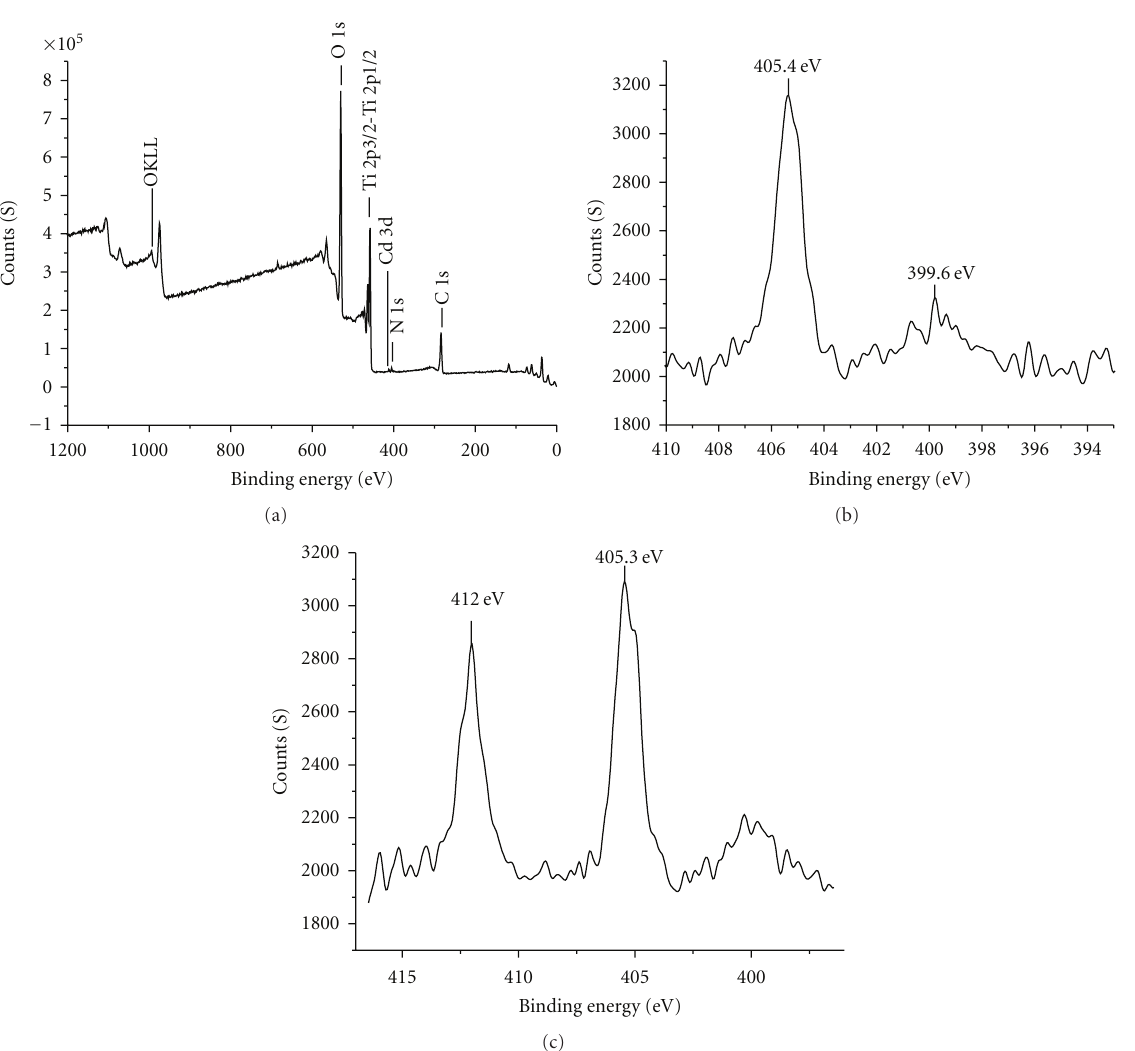
Figure 4: (a) The survey XPS spectra of N, Cd-TiO 2 , (b) N 1s XPS spectra of N, Cd-TiO 2 , (c) Cd 3d XPS spectra of N, Cd-TiO 2